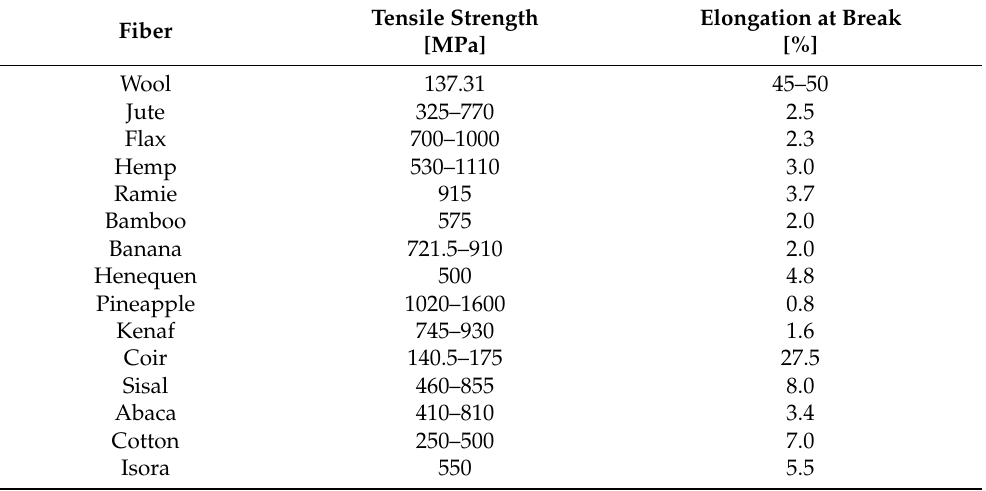
Table 2. Mechanical properties of some common vegetable fibers, re-elaborated from Parlato et al.